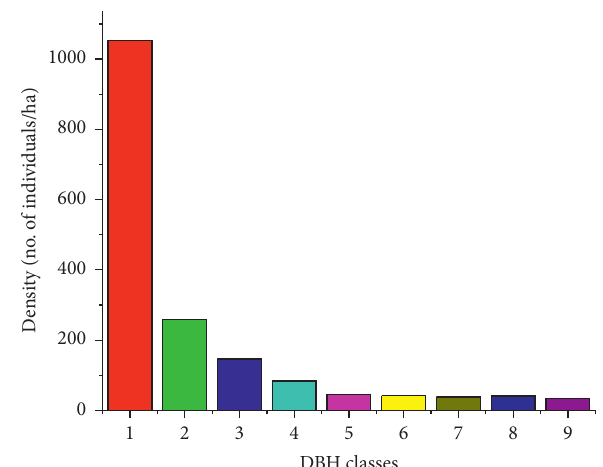
Figure 5: Density of individuals of woody plants in different DBH classes.